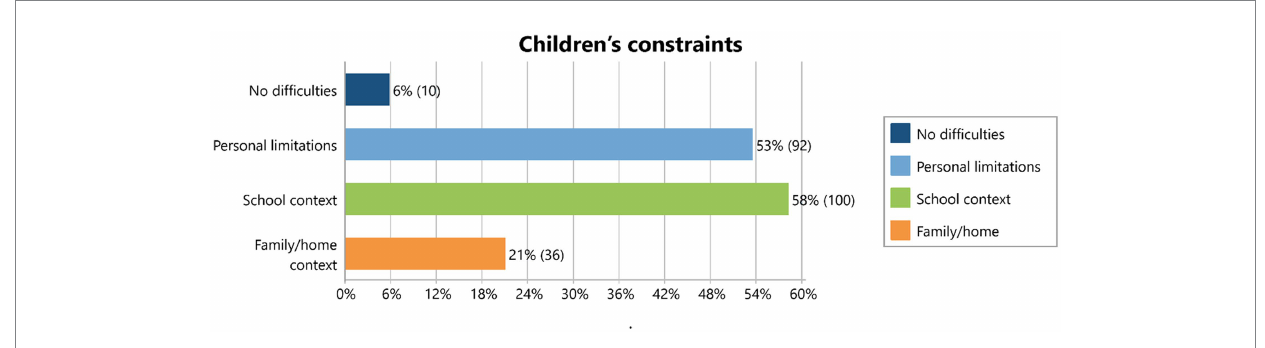
FIGURE 4 Frequency of documents referring to each subcategory within Children’s